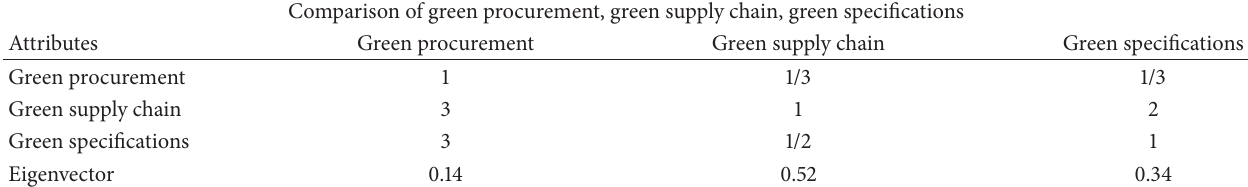
Table 7: Weighting value of procurement criteria.